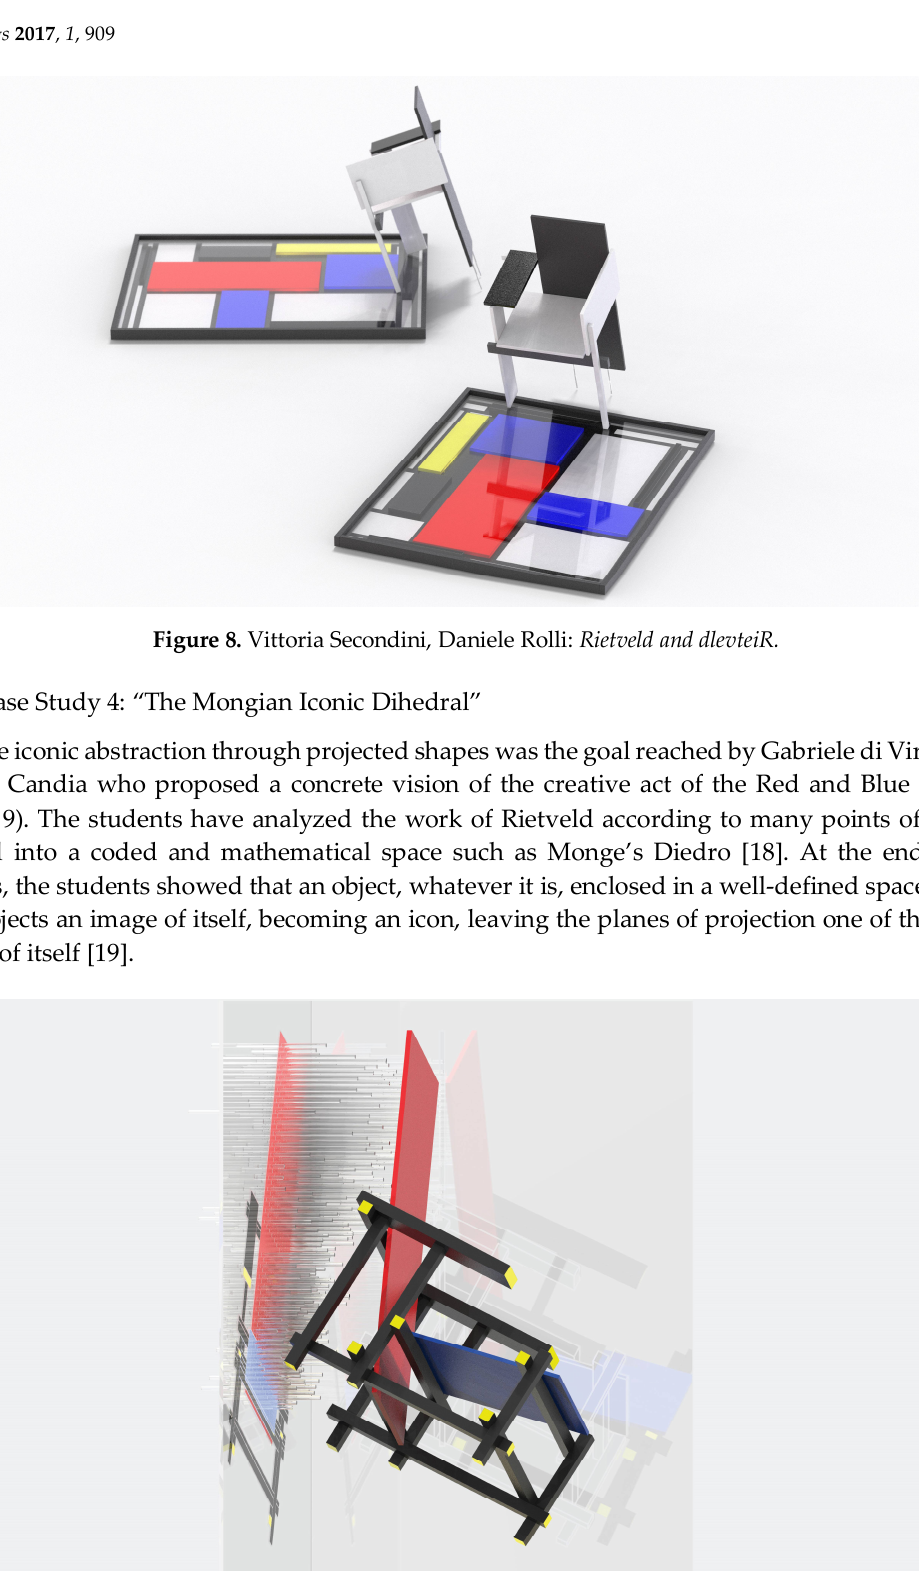
Figure 9. Gabriele di Virgilio, Ciro de Candia: The Mongian Iconic